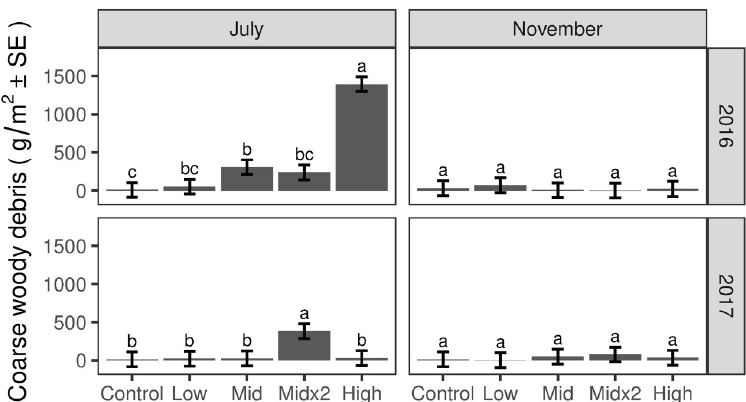
Fig 6. Post-icing coarse woody debris mass for July and November 2016 and 2017. Different letters denote significant differences among treatments ( P < 0.05) within a sampling period. Vertical lines are 95% confidence